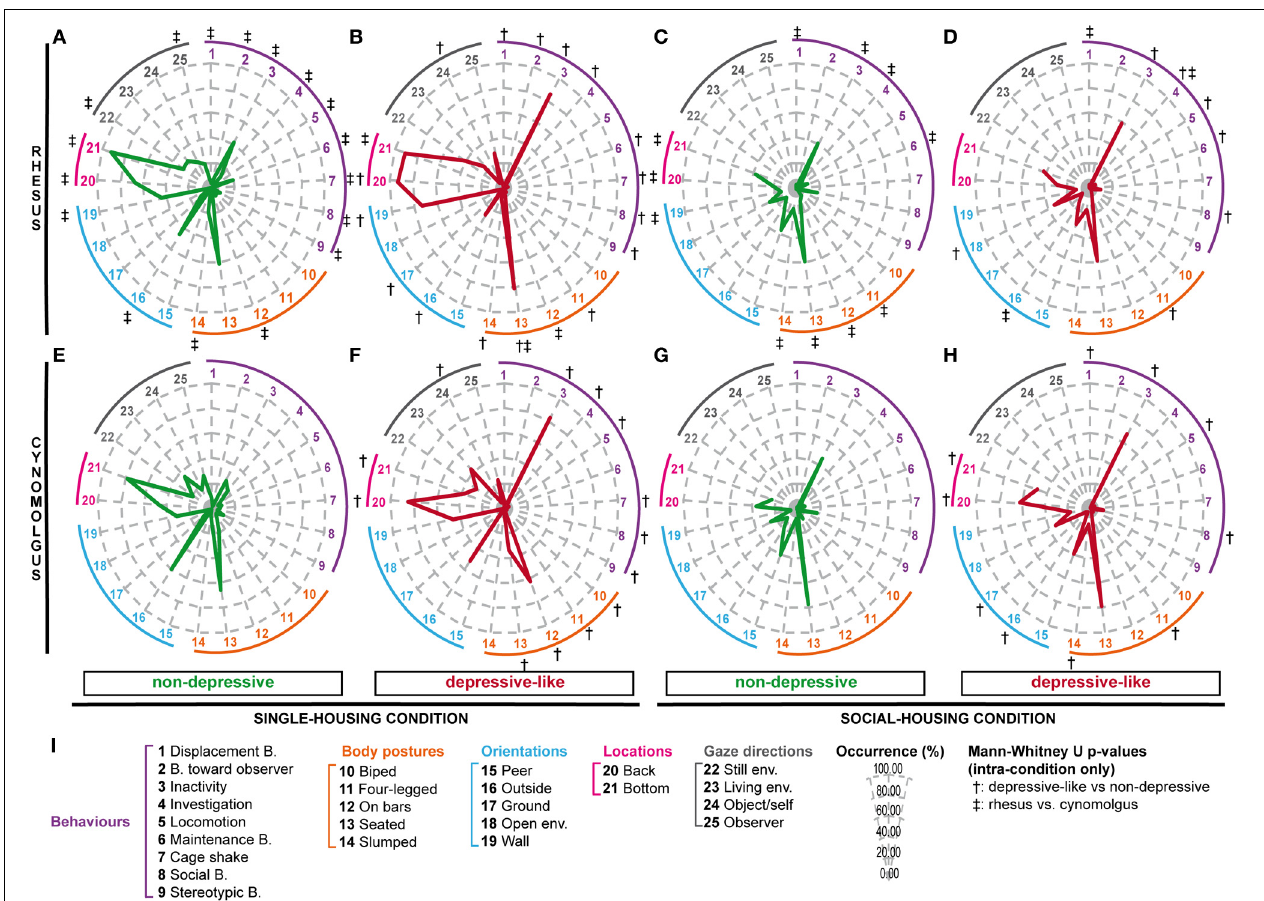
FIGURE 1 | Depressive-like and non-depressive behavioral profiles resulting from hierarchical cluster analyses among single- and socially-housed rhesus and cynomolgus macaques. Rhesus (A–D) and cynomolgus (E–H) monkeys were observed in single- (A,B,E,F) or social-housing (C,D,G,H) conditions. Following multiple component and hierarchical cluster analyses, the observed populations were divided into depressive-like (B,D,F,H) and non-depressive (A,C,E,G) groups, containing n A = 22, n B = 18, n C = 29, n D = 6, n E = 33, n F = 4, n G = 75, and n H = 5 animals. The mean percentages of occurrence were calculated among the 8 groups for a selection of collected variables (I) . Each axis of the radar